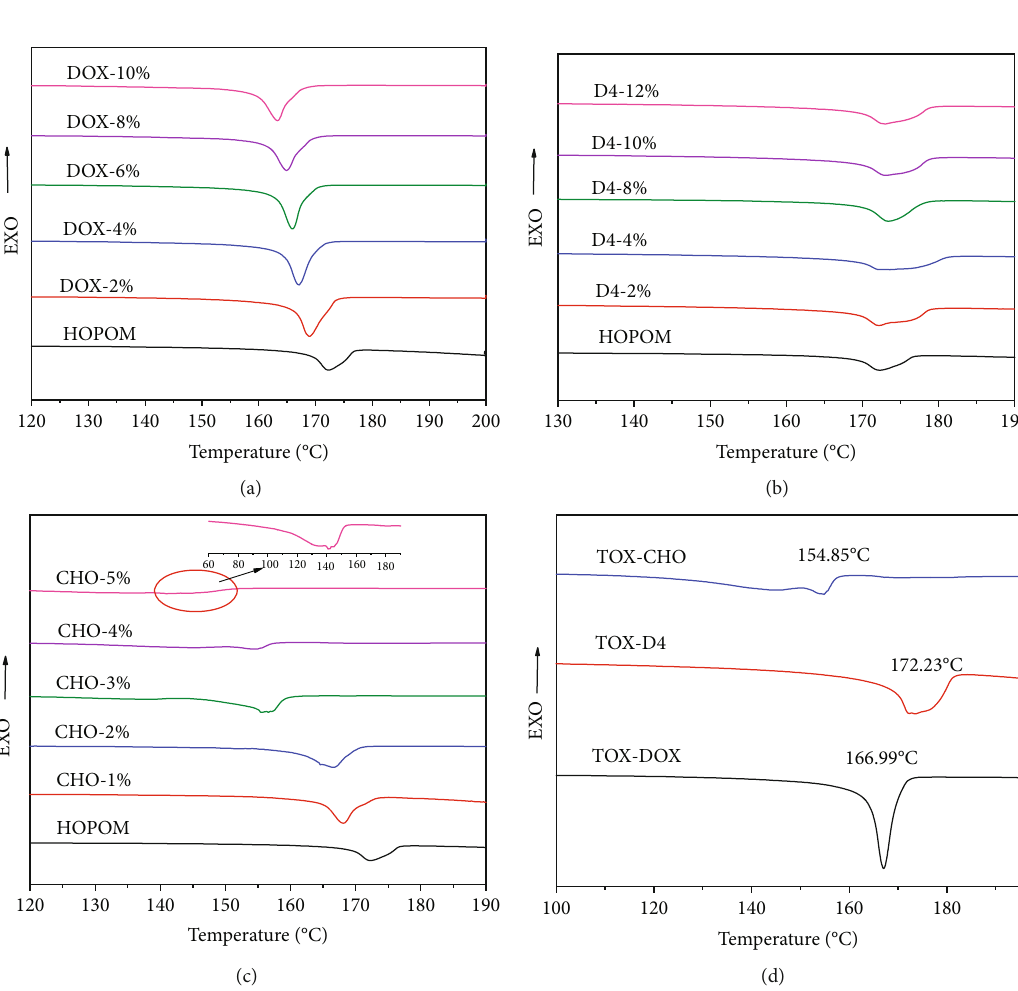
Figure 4: DSC curve of the copolymer. (a) Changes in the dosage of DOX. (b) Changes in the dosage of D4. (c) Changes in the dosage of CHO. (d) Comparison of the second monomers (4